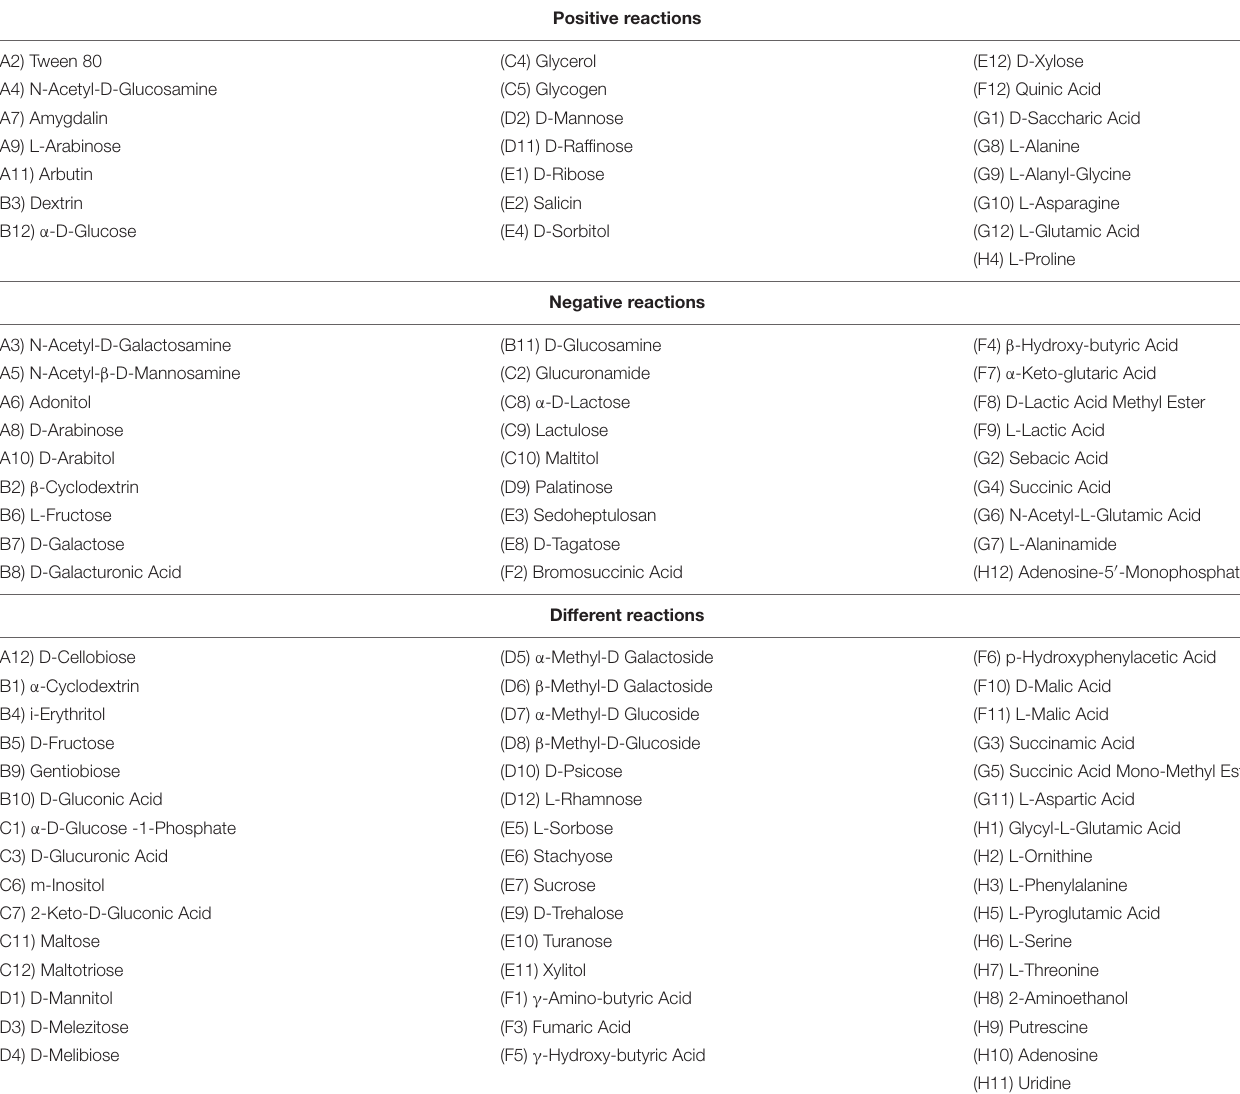
TABLE 2 | Comparison of the results of phenotypic (biochemical) identification profiles of Aspergillus niger environmental isolates obtained by the Biolog system. Positive